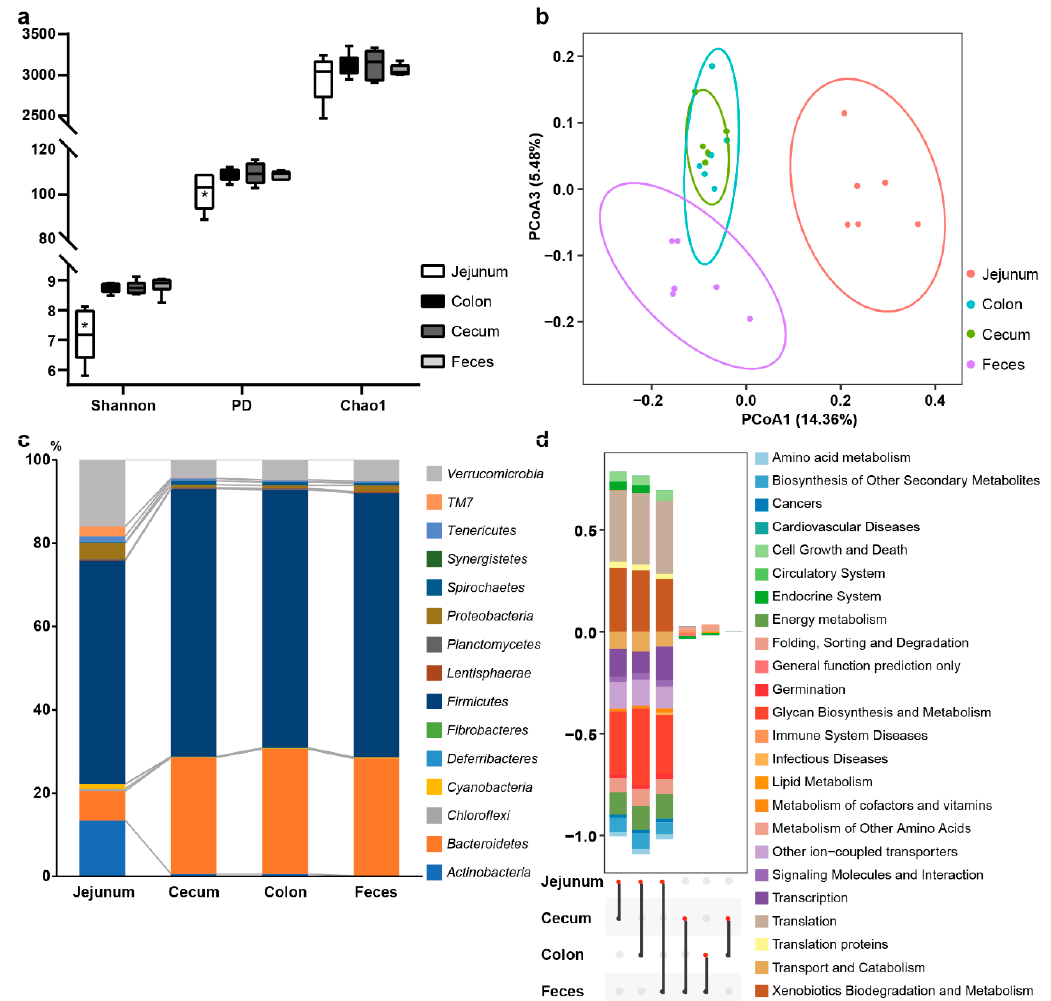
Figure 3. The similar and different of intestinal microbial communities in different intestinal sites. ( a ) Bacterial alpha diversity based on Shannon diversity, PD (Phylogenetic diversity), and Chao1 index. * on jejunum box indicates there was significant difference in alpha diversity between jejunum and other 3 groups ( p < 0.05). ( b ) PCoA plot, based on the Bray Curtis dissimilarity of microbiota. Each dot represented the composition of the microbiota of each sample. Samples were grouped by colors as label showed. ( c ) Bar plot indicated the bacterial taxonomic composition and the change of relative abundance at phylum level of jejunum, cecum, colon, and feces. The microbial relative abundance of jejunum was significantly different from that of the other three sites at phylum level. ( d ) Stacked bar chart represented pathways ( n = 24) with significant differences between 2 groups (bottom-colored spots). The upper x axis KEGG pathways displayed pathways, with greater number of OTUs in the red dot group than that in the black dot group, while that in the lower x axis was opposite. The height of each colored bar indicated the difference between the two groups.